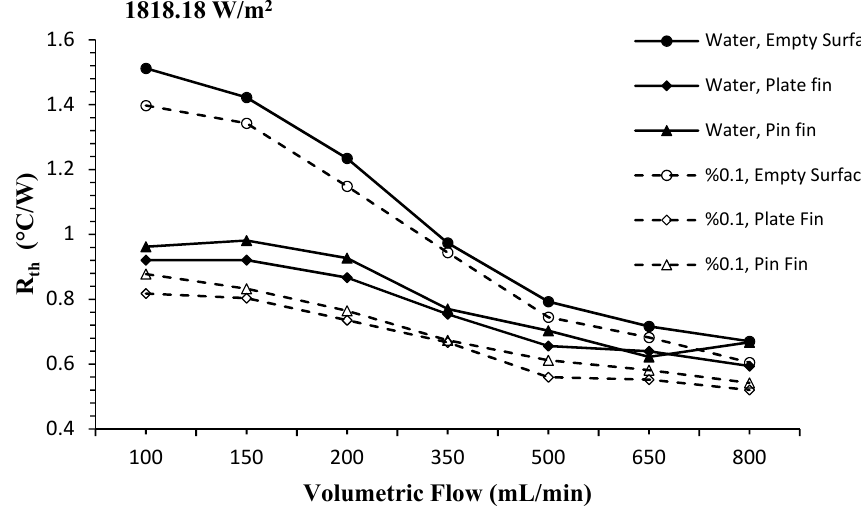
Figure 9. Variations of thermal resistance at different volumetric flow rates. To compare the thermal performance of the nanofluid with the base fluid, the empty surface was taken as a reference. The graph showing the variation of the thermal perfor- mance of the nanofluid with different volumetric flow rates was drawn for 454.54 W/m 2 in Figure 10. As a result of the calculations, it was observed that the heat transfer perfor- mance of the nanofluid was much higher than the base fluid. An increase in the thermal performance of nanofluids was observed with increasing volumetric flow rate. Slight fluc- tuations in the thermal performance occurred at certain volumetric flow rates. It was esti- mated that these fluctuations in thermal performance were due to the increased volumet- ric flow rate and the inability of the nanofluid to have sufficient time for heat transfer within the water block. Similar results were seen in the experimental work of Shah et al. [11]. In addition, the thermal performance of the nanofluid in the figure was compared with other studies in the literature [2,3] using a water block and Al 2 O 3 -H 2 O nanofluid. The thermal performance of the nanofluid that was used in this study was found to be close to the thermal performance values that were obtained from the studies. The differences seen in the graph between the studies occurred due to the concentration of the nanofluid, the geometry of the test region, and the parameters of the studies.